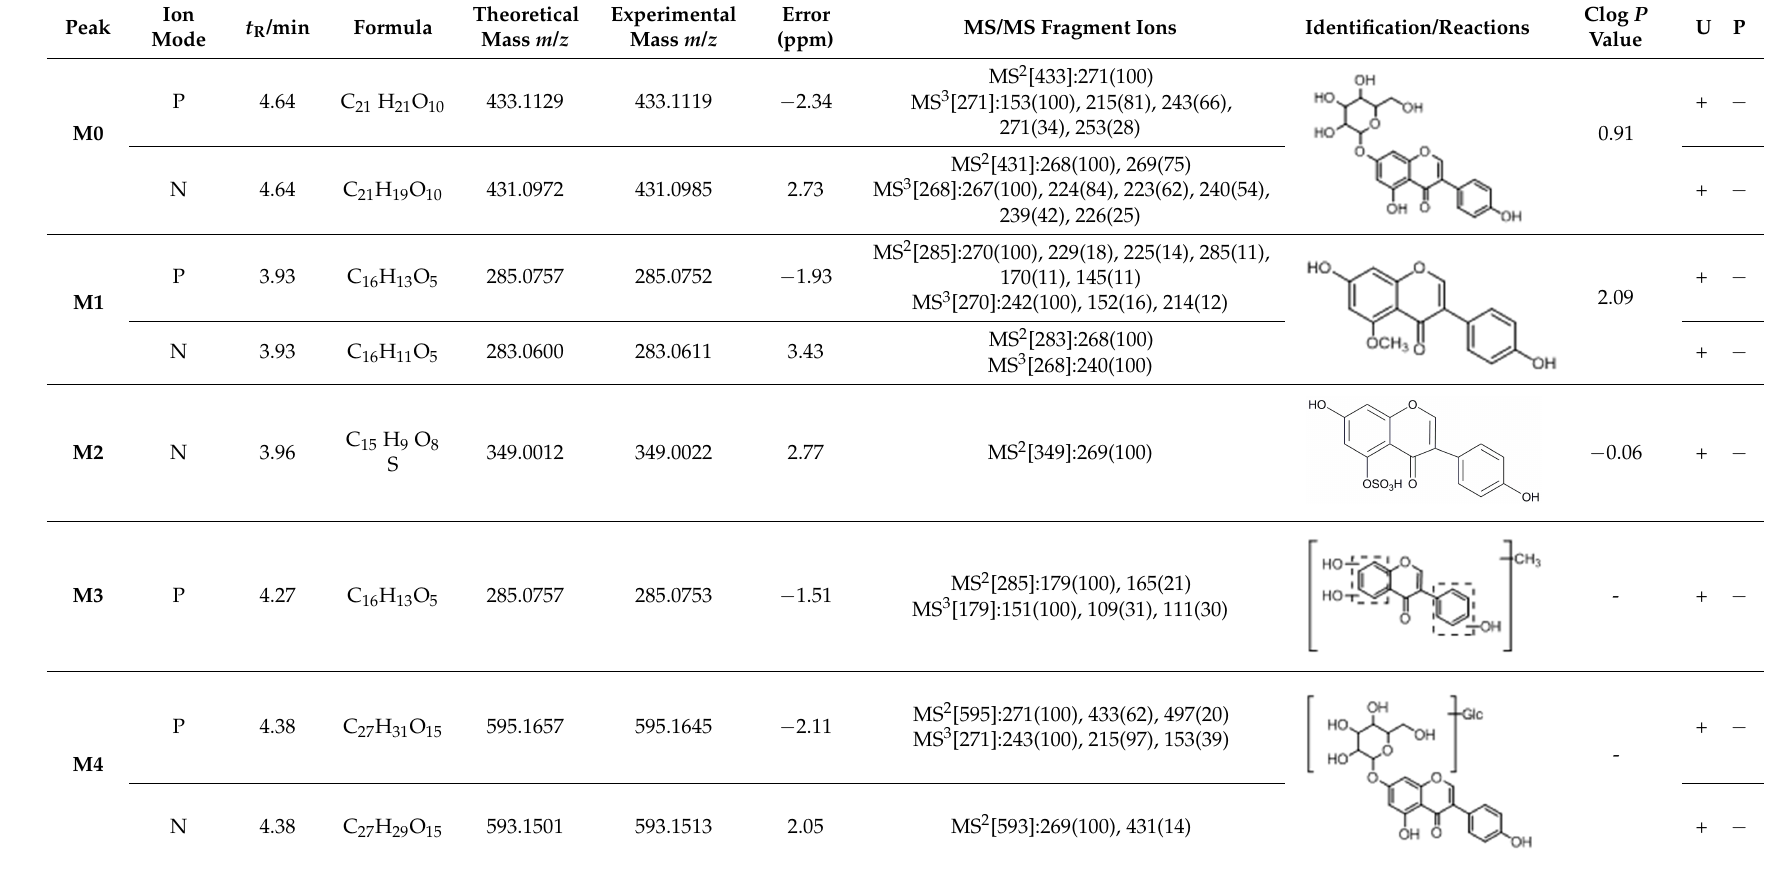
Table 1. Summary of genistin metabolites in rat urine and plasma by HPLC-LTQ-Orb.